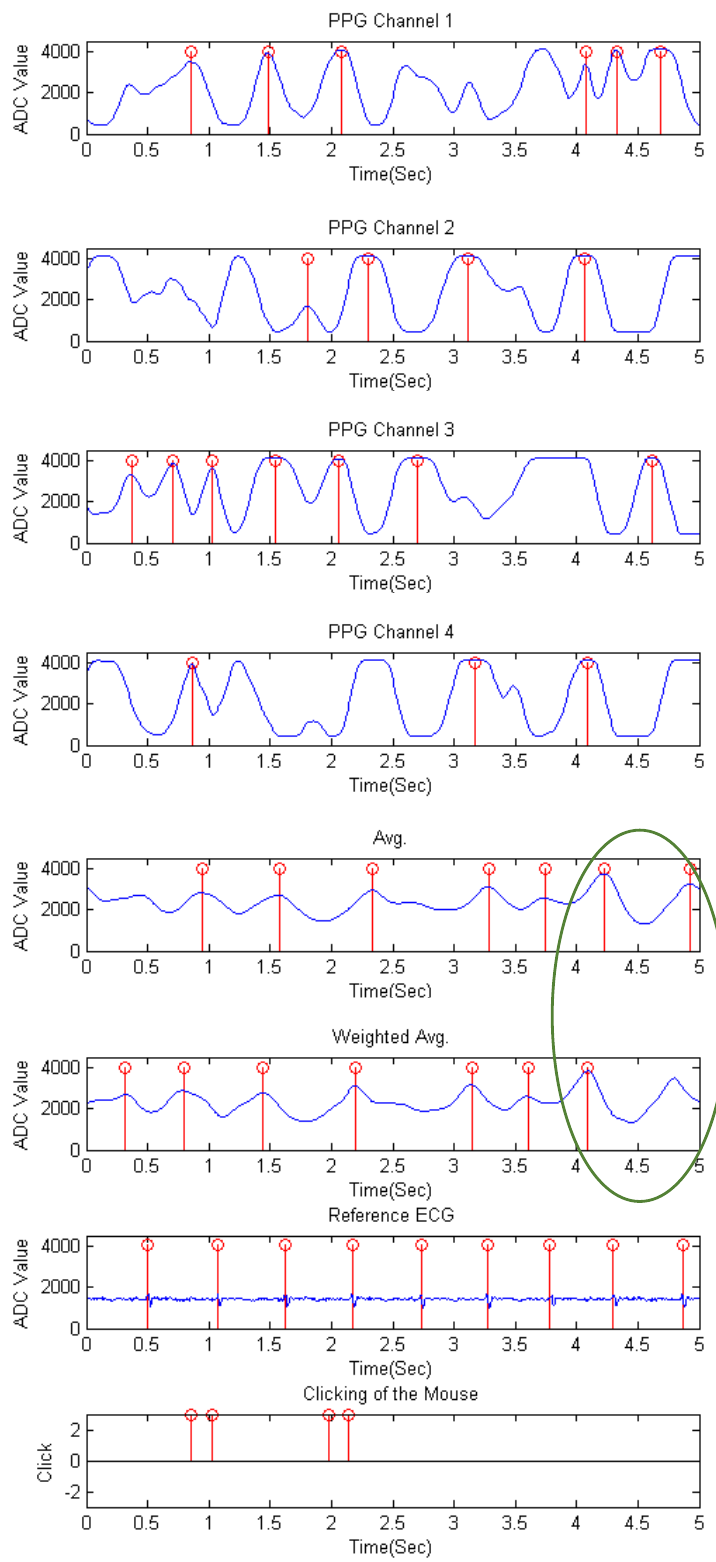
Figure 8. The waveforms of the browsing stage of each channel, the mixed waveforms by the average and the weighted average method, the reference ECG signal, and the clicking of the mouse for subject